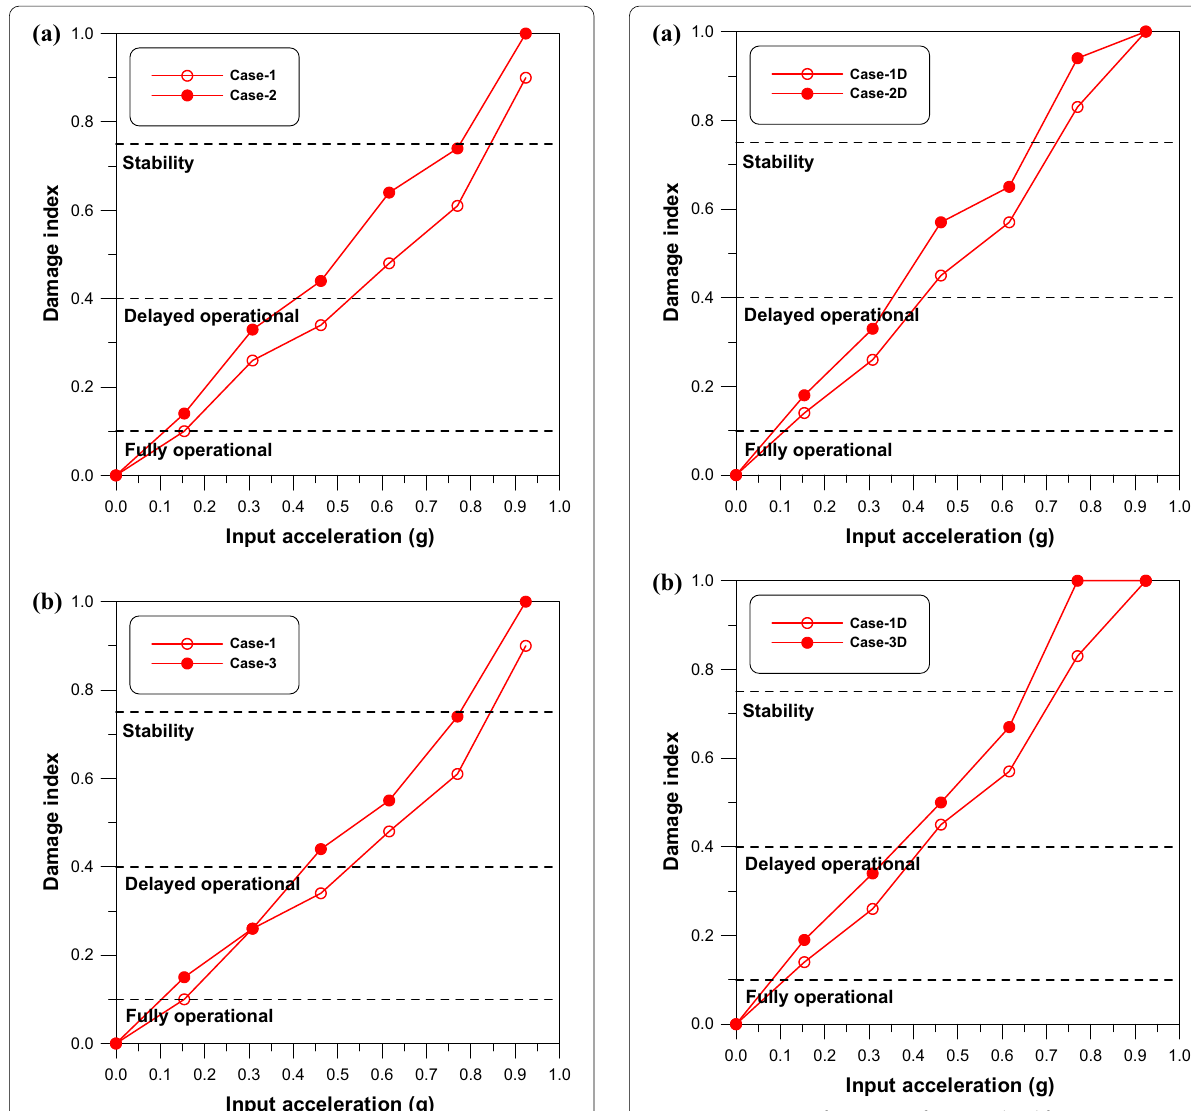
Fig. 15 Assessment of seismic performance level for cases: a Case‑1D and Case‑2D and b Case‑1D and